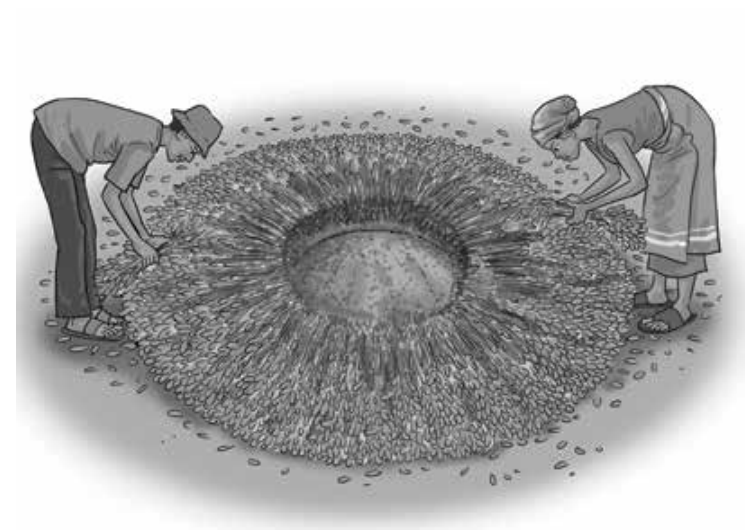
Figure 4: Mandela cock: layers of groundnut plants placed on top of soil